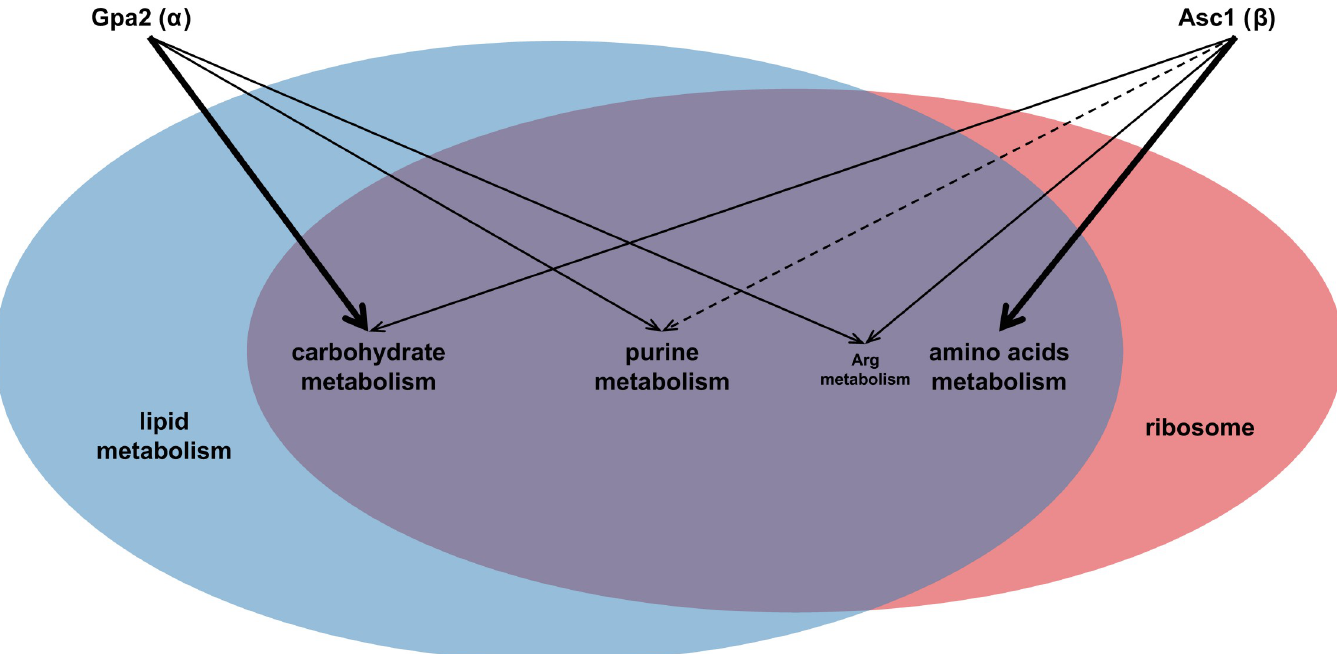
Fig 9. Summary of interactions. Gpa2 is primarily involved in regulating carbohydrate metabolism while Asc1 is primarily involved in amino acid metabolism, as indicated with thick lines (concentration analysis). Gpa2 and Asc1 have shared effects on arginine metabolism and opposing effects on purine metabolism, as indicated with solid and dashed lines (concentration analysis). Gpa2 regulates a greater number of gene transcripts and was particularly important in determining the amplitude of response to glucose addition, as indicated with the larger sphere (sensitivity